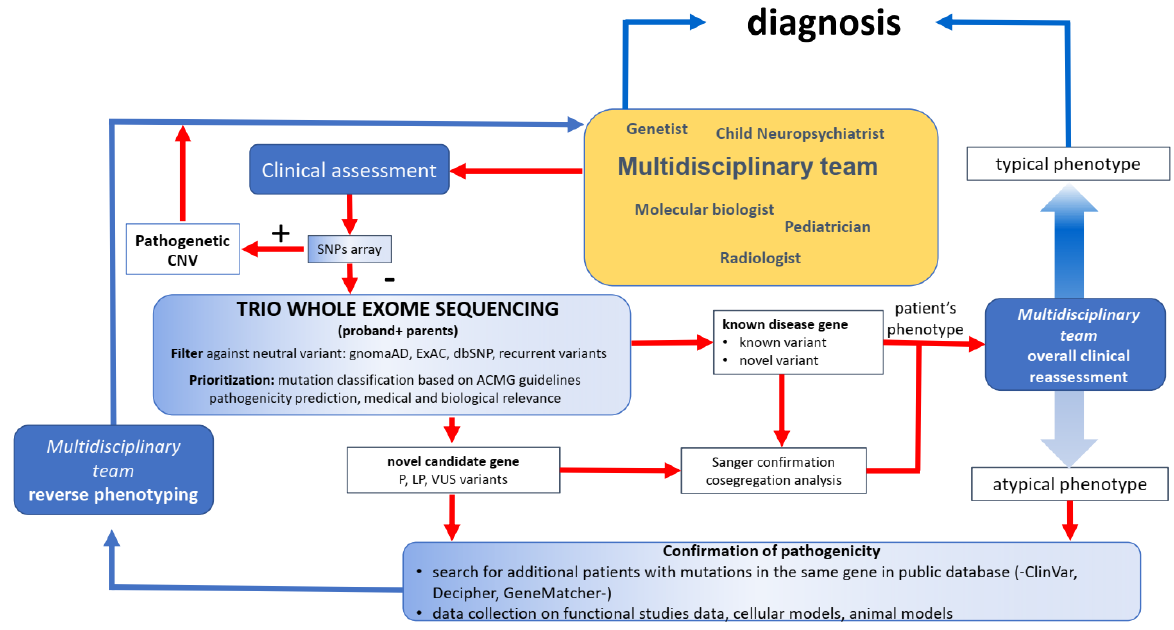
Figure 1. Schematic of the diagnostic procedure used in this study. The flow starts with the multidisciplinary team (yellow box) and goes to clinical assessment, molecular tests, and Sanger confirmations and cosegregation analysis (red arrows) and reaches the ending point (diagnosis) through a confirmation path (blue arrows) which includes clinical reassessment using a reverse phenotyping strategy. Abbreviations: SNP: single nucleotide polymorphism; CNV: copy number variation; gno-